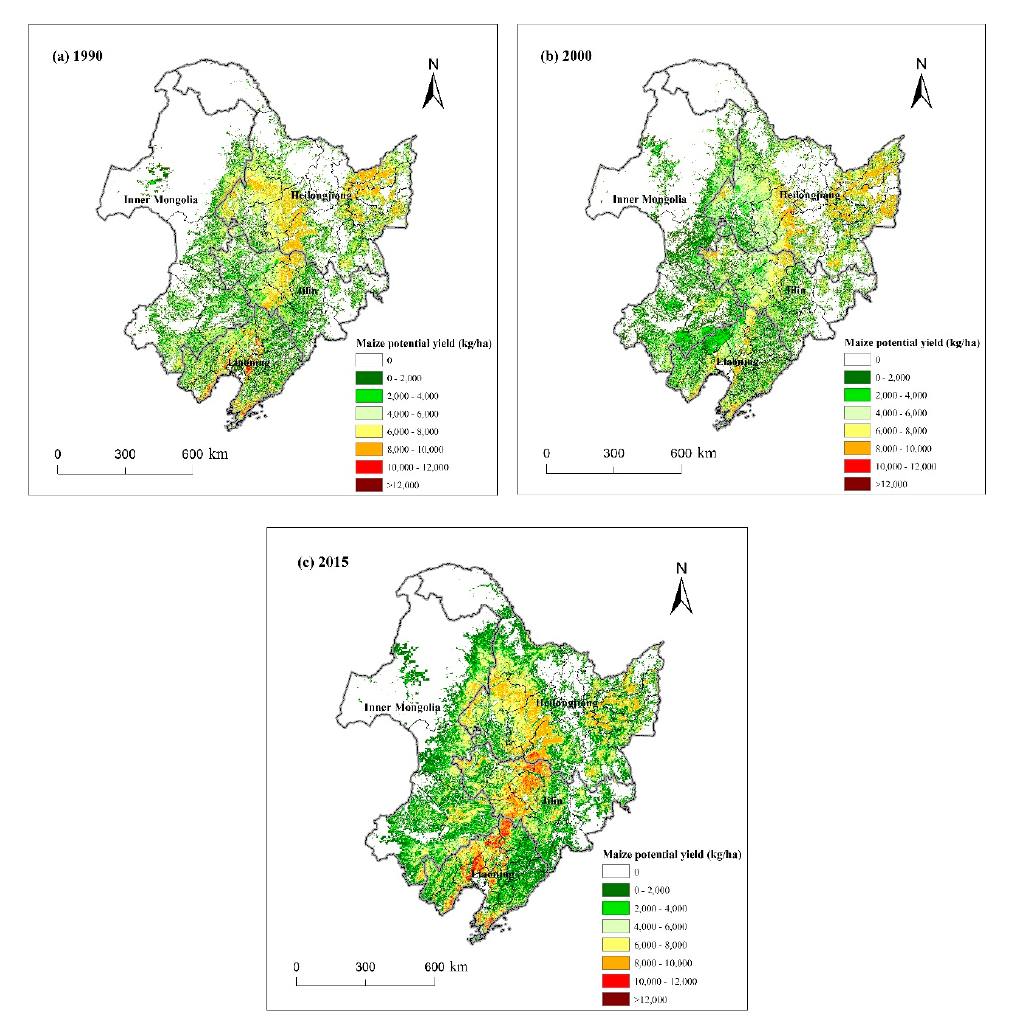
Figure 6. Maize potential yield from 1990 to 2015 in Northeast China. (a) 1990; (b) 2000; (c)